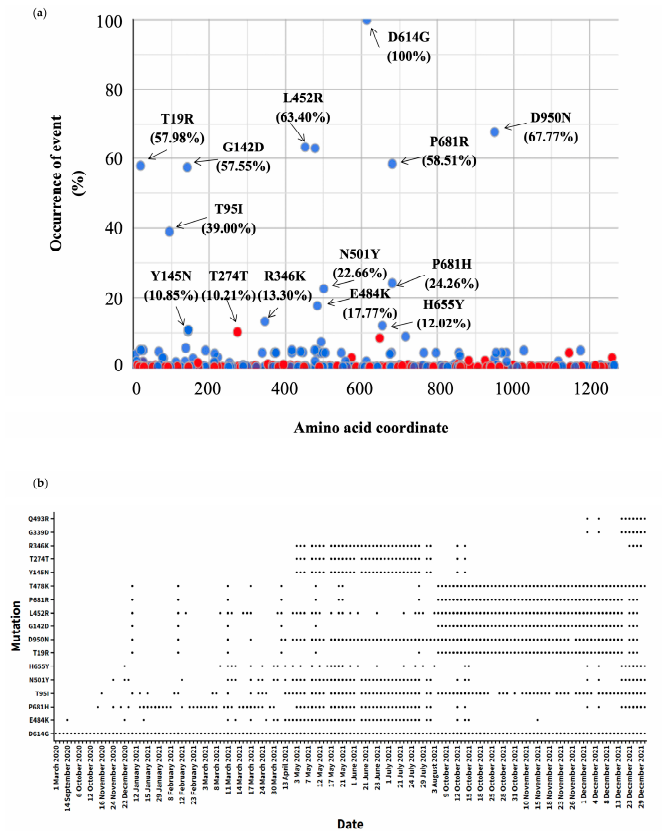
Figure 3. Monitoring and identification of SARS-CoV-2 spike mutations. ( a ) Three hundred and ninety-three different mutations were detected in the sequences (n = 940) used in the evaluation. The webtool coronapp was used to determine the mutations (mutation frequency for S protein (spike) in percent). Blue and red colors indicate amino acid changes and silent mutations, respectively. The arrows indicate the mutation. ( b ) Distribution of the most relevant mutations in the spike protein (X > 10%) and two key Omicron mutations (G339D, Q493R) through time. The black spots represent the detection of the mutation through time. describing the SARS-CoV-2 viral evolution dynamics. The demographic reconstruction shows an initial short lag phase, after which the epidemic experienced a fast exponential